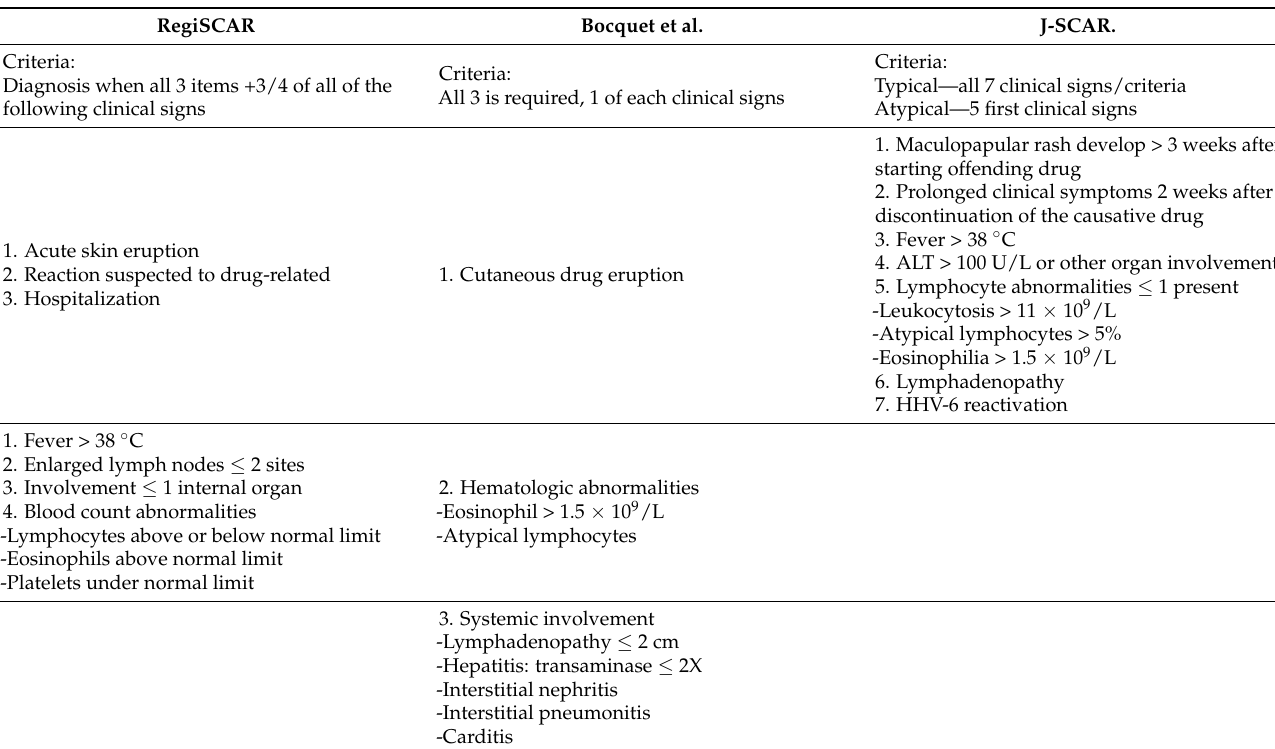
Table 2. Diagnostic criteria for drug reactions with eosinophilia and systemic symptoms